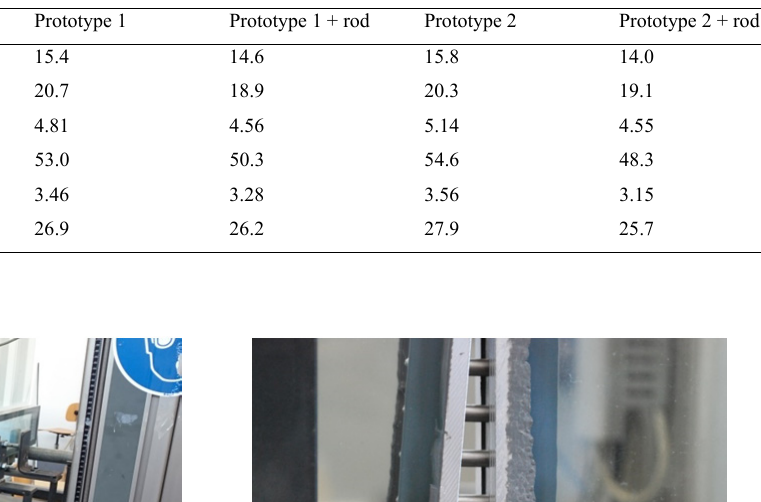
Table 2: Results of the load tests, displayed values just before ultimate failure.